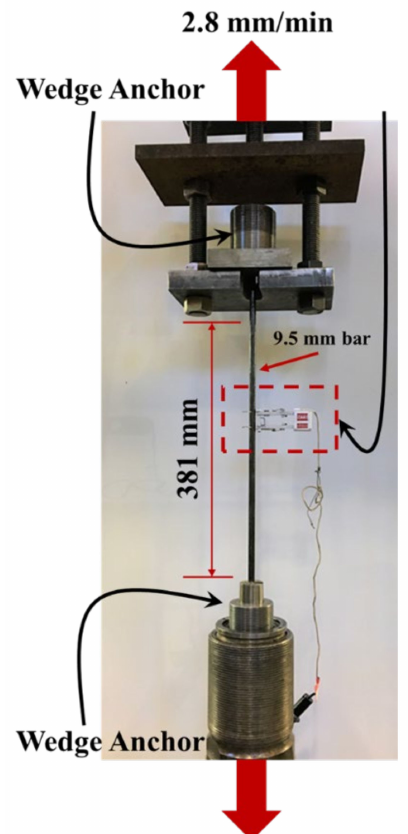
Figure 3. Longitudinal tension test setup of pultruded GFRP bars using mechanical wedge